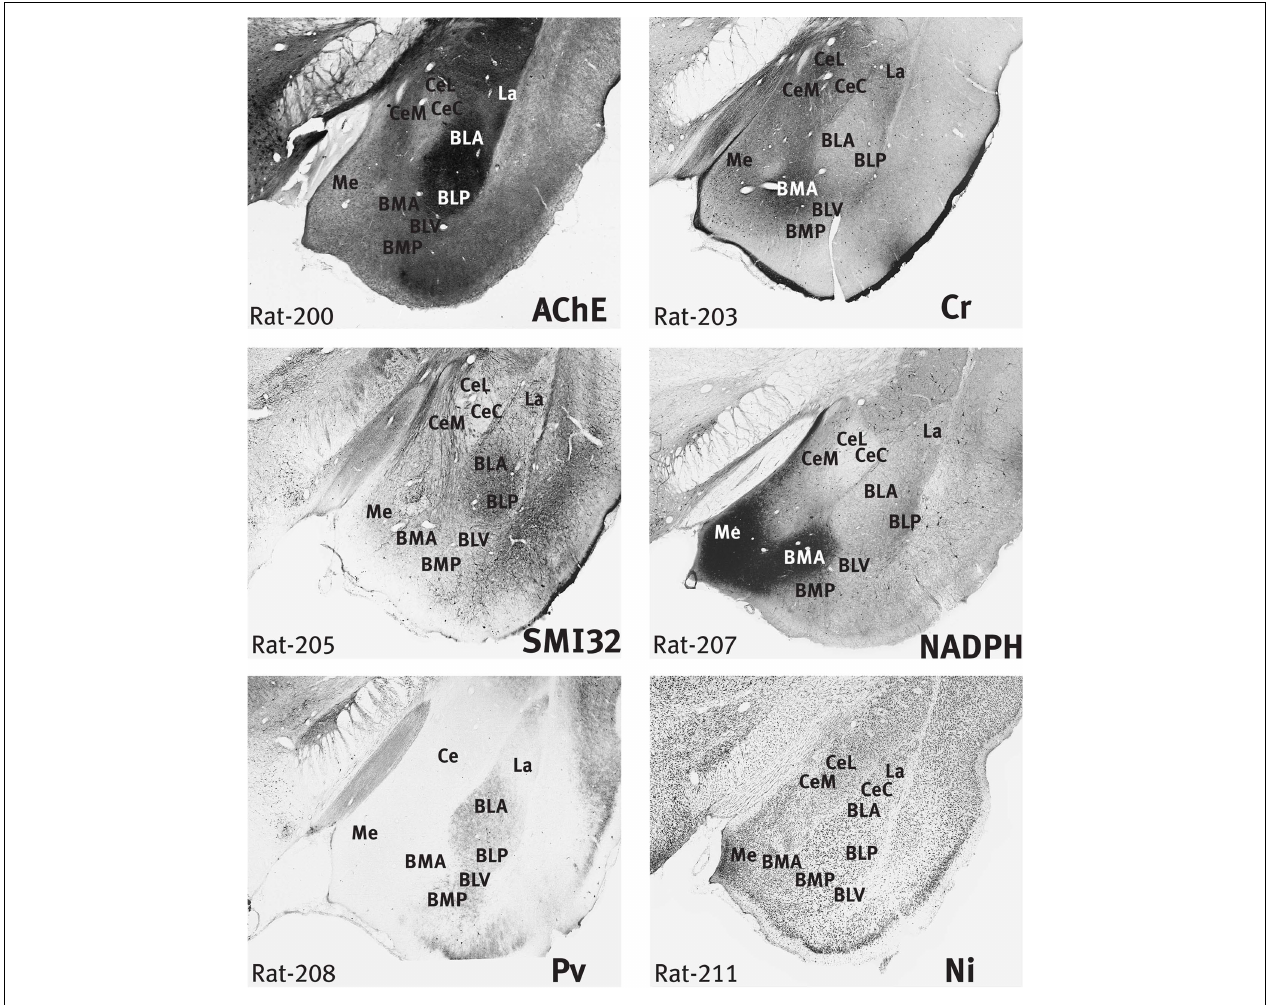
FIGURE 2 | Rat amygdala. Six images of the rat brain taken from the stained sections used in the preparation of the atlas of Paxinos et al. (2009b), but note that the AChE section is not displayed in the atlas. The sections are numbered from rostral to caudal, and the section thickness is 0.04 mm. The section number is indicated at the lower left. The stain in each case is indicated at the lower right of the section. Scale – the fi eld of view in